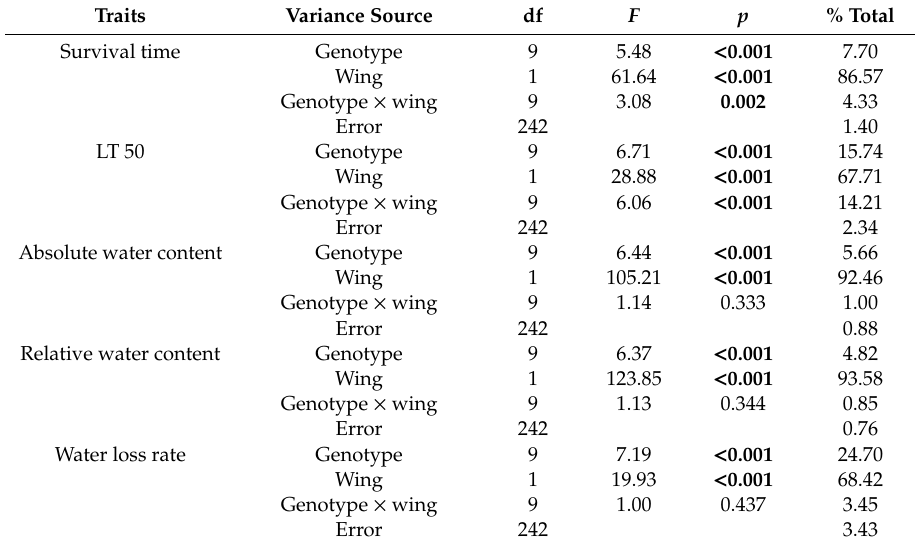
Table 1. Estimates of variance components for desiccation-related traits of Sitobion avenae .